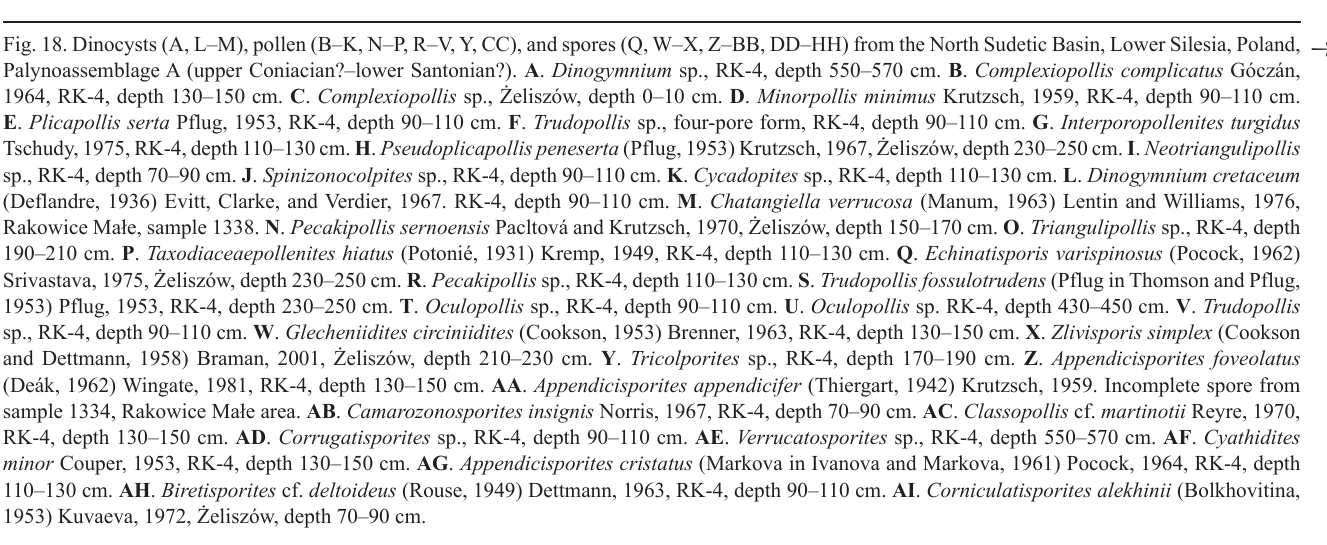
Fig. 18. Dinocysts (A, L–M), pollen (B–K, N–P, R–V, Y, CC), and spores (Q, W–X, Z–BB, DD–HH) from the North Sudetic Basin, Lower Silesia, Poland, Palynoassemblage A (upper Coniacian?–lower Santonian?). A . Dinogymnium sp., RK-4, depth 550–570 cm. B . Complexiopollis complicatus